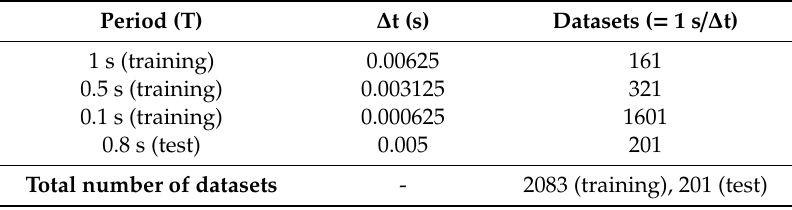
Figure 5. Sine loads applied to the simple beam. Table 2. The number of datasets for ANN training and testing.